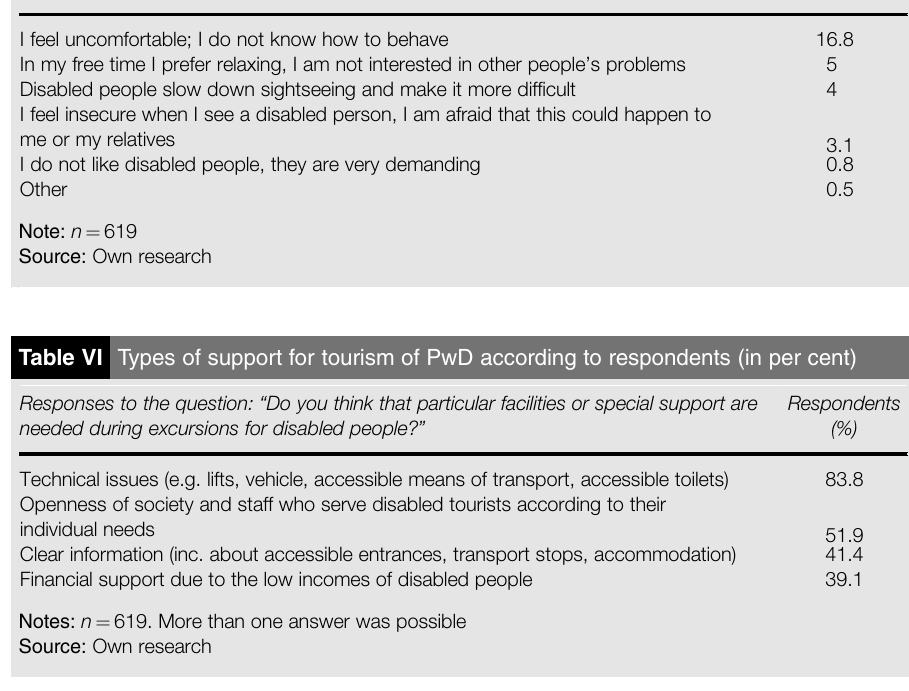
Table V Reasons for not wishing to spend free time with PwD Type of